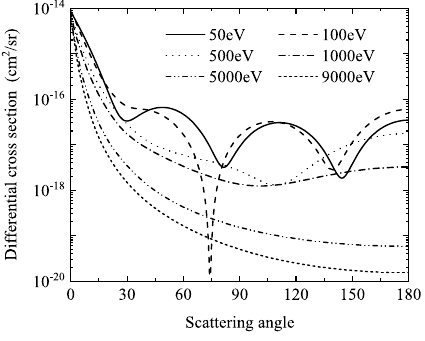
Figure 2. DCS of total cross section of atomic Fe at di ff erent incident electron energy